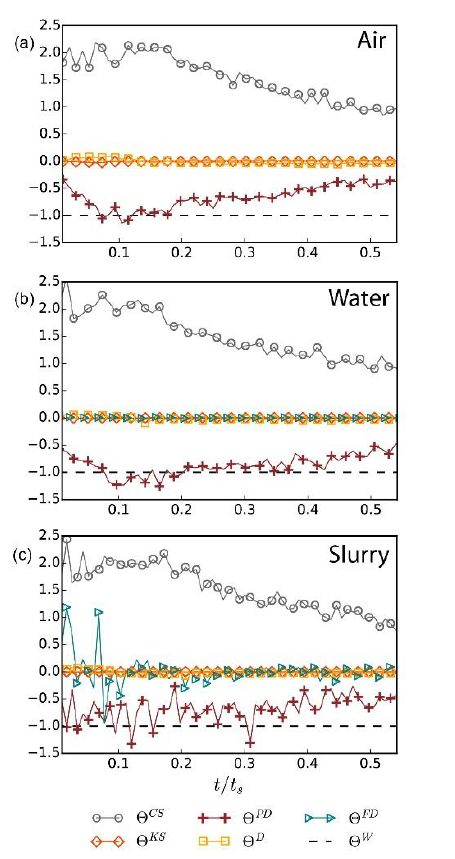
Fig. 4. The evolution of depth-averaged segregation forcing terms evaluated in Eq. 9 for different ambient